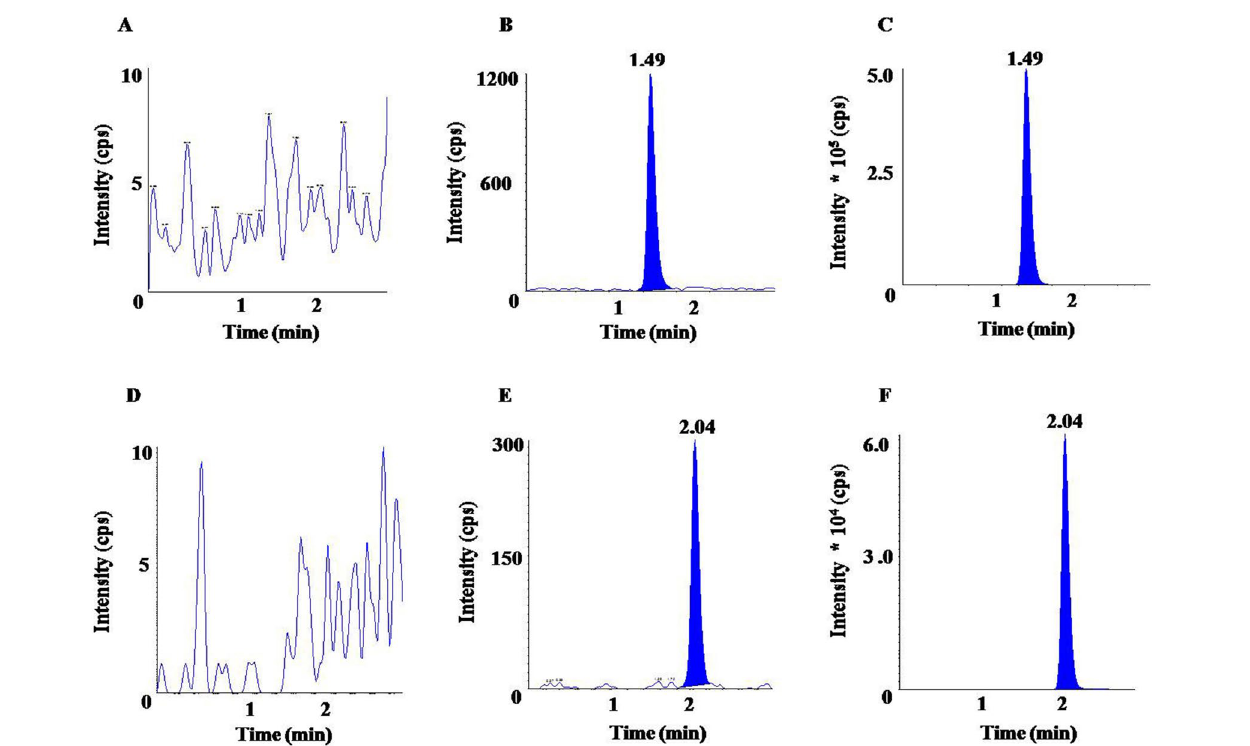
FIGURE 2 | Chromatograms of OLM for (A) blank, (B) LLOQ (lower limit of quantification), (C) upper limit of quantification (ULOQ); and chromatograms of HCTZ for (D) blank, (E) LLOQ, (F)